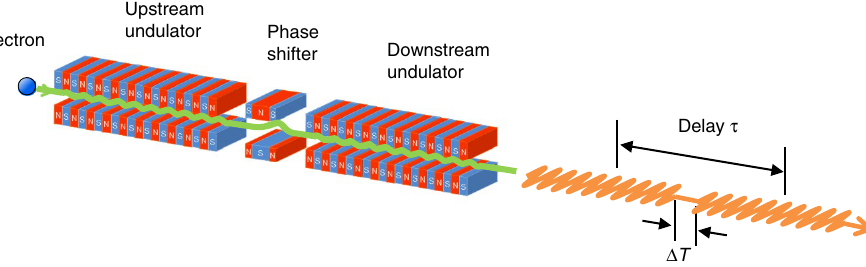
Figure 6. Schematic illustration of the tandem undulator. The period length and number of periods for each undulator is 88 mm and 10, respectively. A relativistic electron passing through the undulators emits a wave packet with a waveform expected to be characterized by time-separated 10-cycle oscillations. The time delay τ between the double-pulsed components of the wave packet is controlled at the attosecond level by changing the field strength of the phase shifter magnet located between the two undulators.